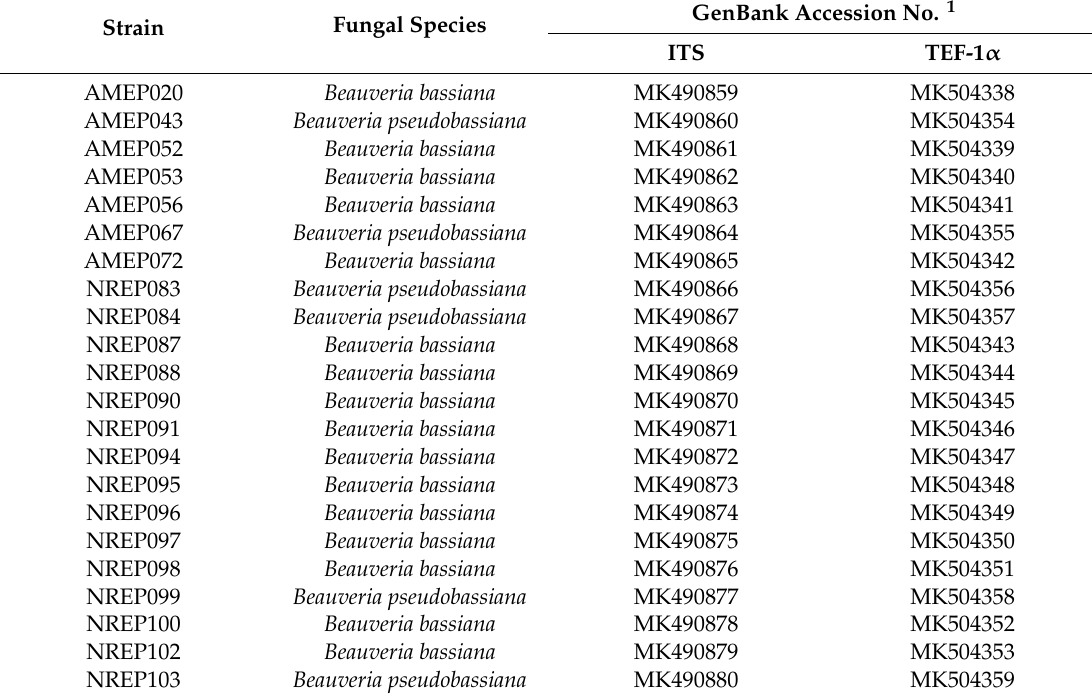
Table 1. List of Beauveria strains isolated from naturally infected adults of Hylobius abietis in Slovakia during